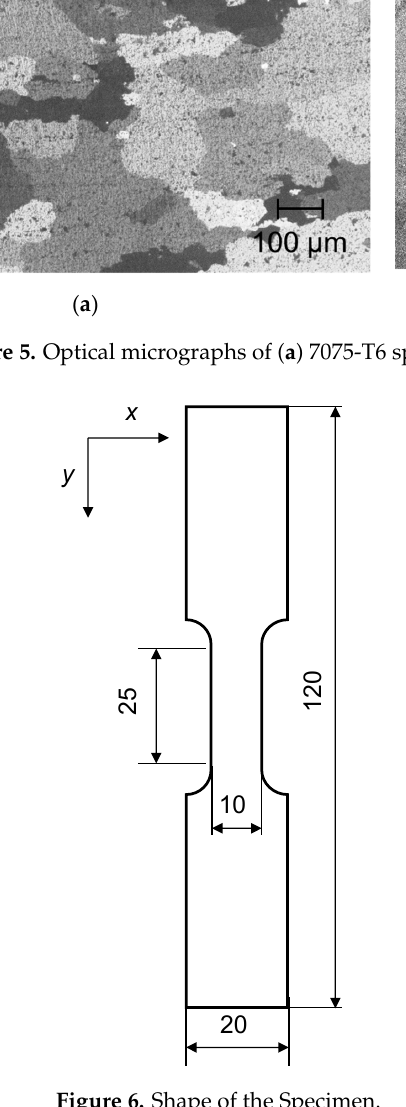
Figure 6. Shape of the Specimen.